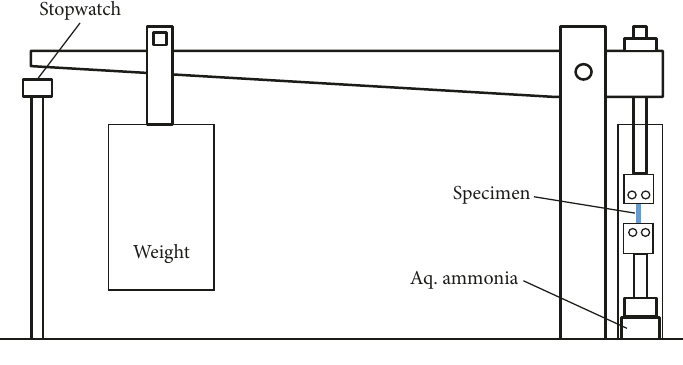
Figure 3: Schematic diagram of the constant-load SCC test.